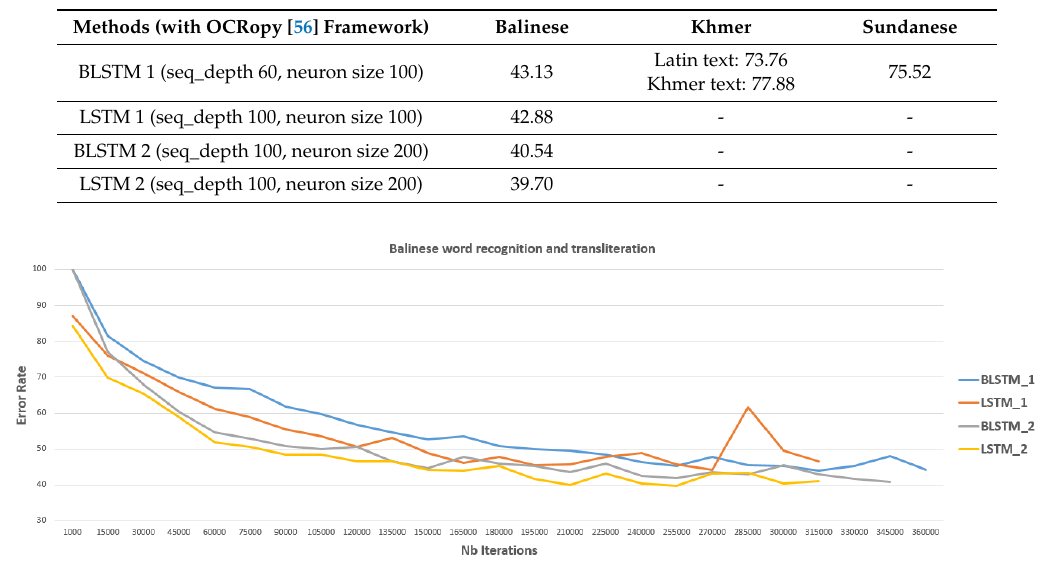
Figure 26. Error rate for Balinese word recognition and transliteration test set.